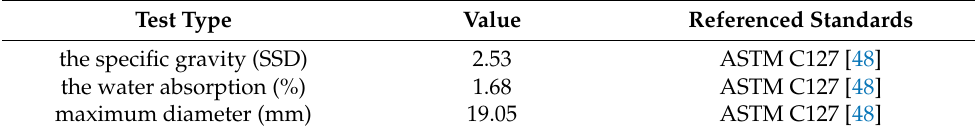
Table 5. Physical properties of natural coarse aggregate.